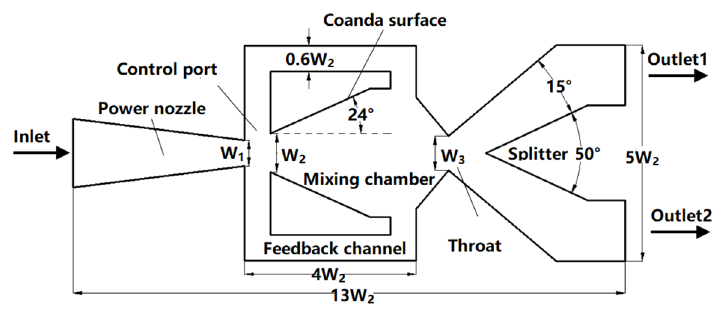
Figure 2. Structure and geometric dimensions of the fluidic oscillator.